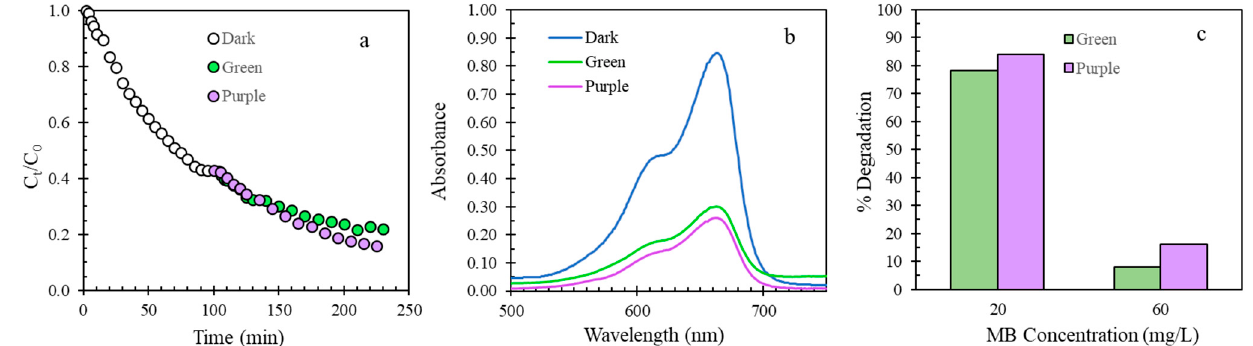
Figure 6. Adsorption and photodegradation under green and purple light of 20 mg/L MB by TPNi: ( a ) change in concentration of MB over time; ( b ) UV-Vis absorption spectra; ( c ) % degradation of 20 mg/L MB versus 60 mg/L MB.